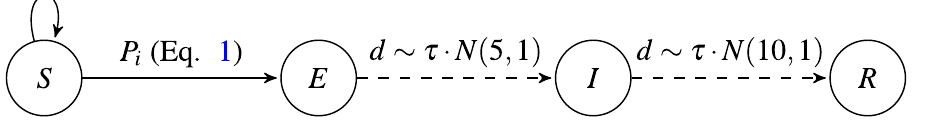
Figure 7. The state machine for each node in our interaction-driven SEIR-like contagion model for random temporal networks. The transition from state S to state E is determined at the end of each time window τ